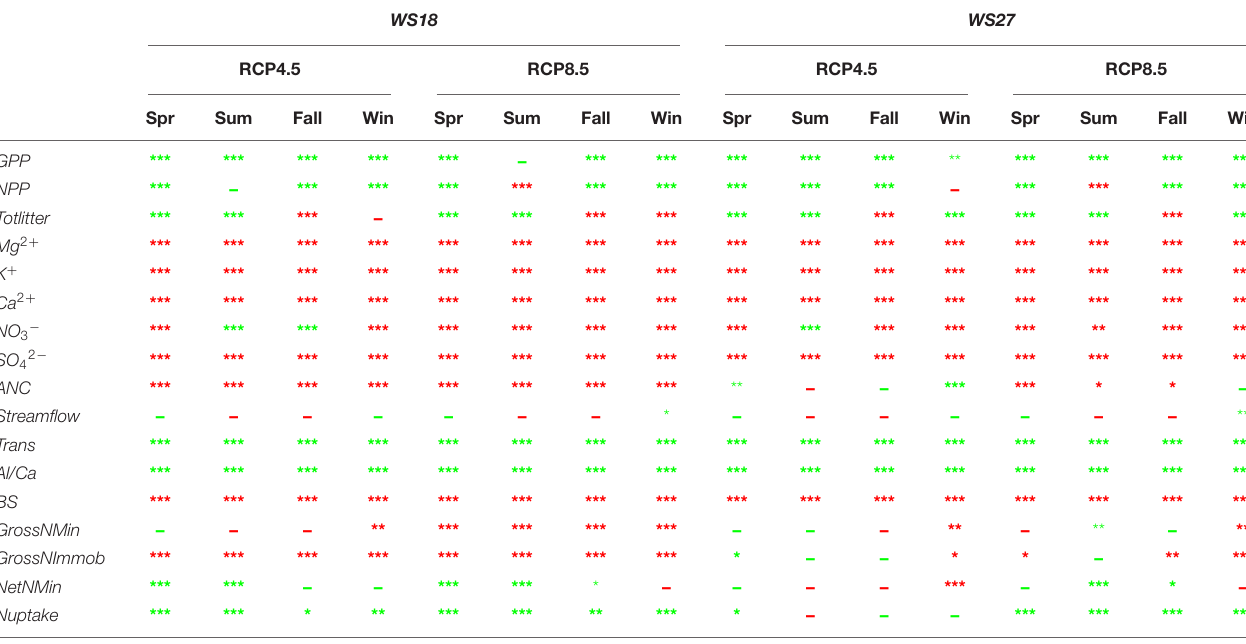
TABLE 3 | Significance test of 17 watershed state variables between current (1986–2015) and future (2071–2100) for the two studied watersheds (GPP, Gross Primary Productivity; NPP, Net Primary Productivity; Totlitter, Total litter produced; ANC, Acid Neutralizing Capacity; Trans, Transpiration; BS, Base Saturation; GrossNMin, Gross Nitrogen mineralization rate; GrossNImmob, Gross Nitrogen Immobilization rate; NetNMin, Net Nitrogen mineralization rate; Nupdate, Nitrogen uptake